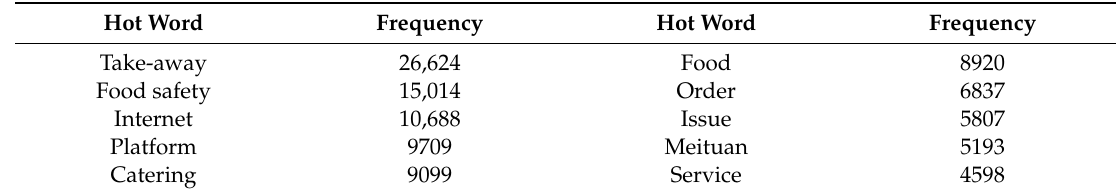
Table 2. The top 10 high-frequency